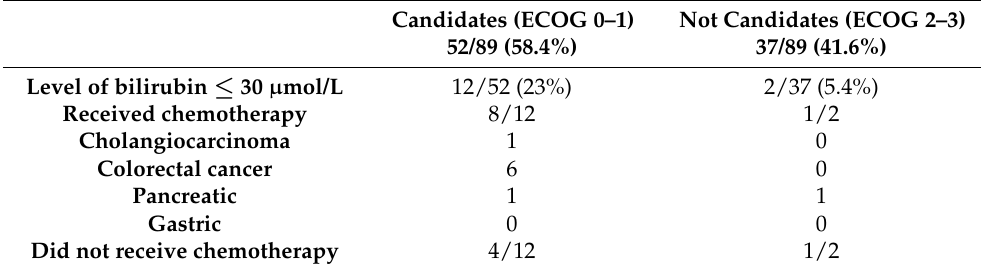
Figure 7. Leukocytes (normal vs. elevated).